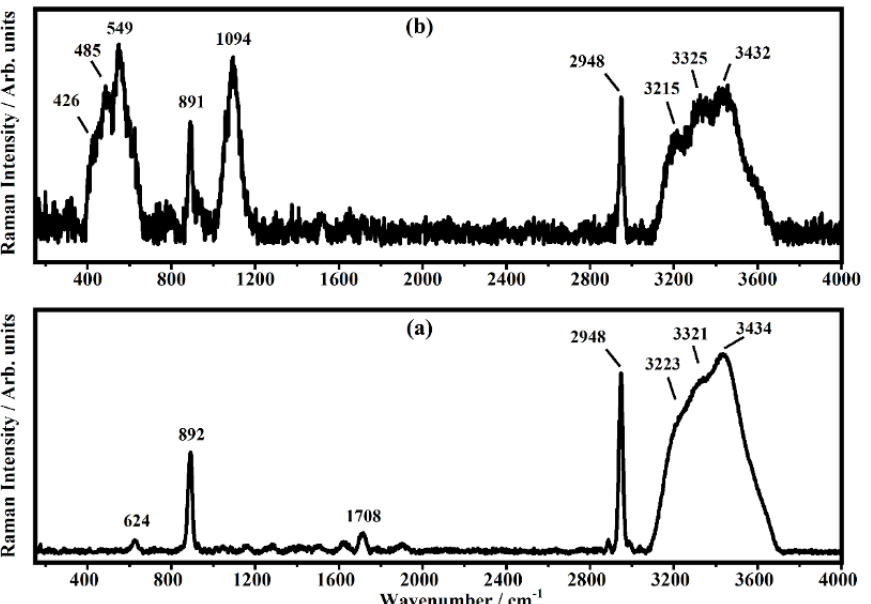
Figure 3. RepresentativeRaman spectra collected on the 10% v / v acetic acid solution ( a ) in a cuvette and ( b ) on the top surfaces of the glass